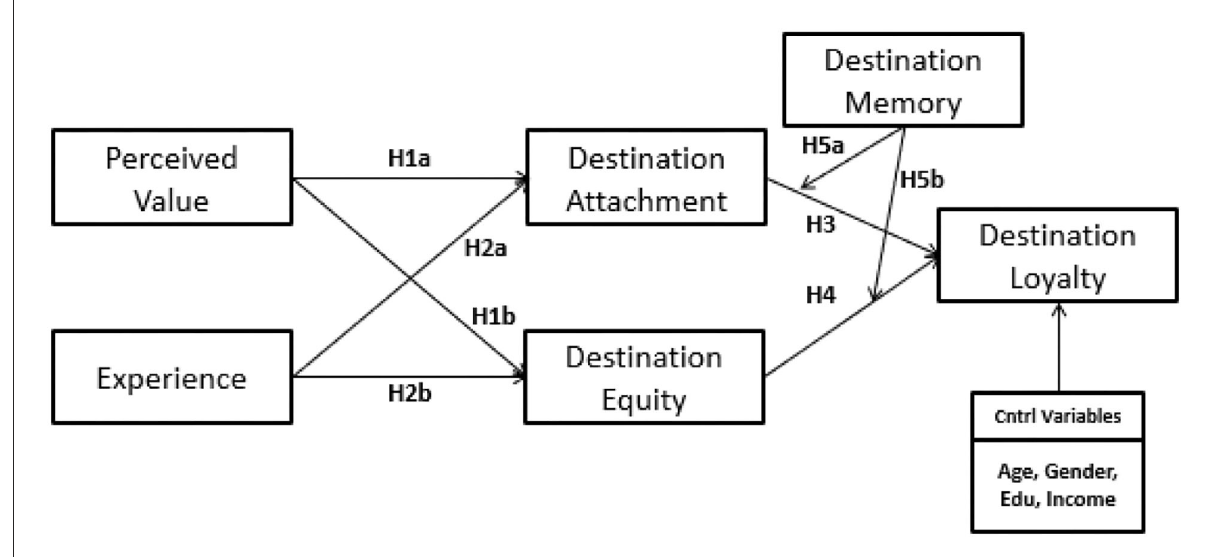
FIGURE1 Analytical framework for the influential factors of destination loyalty.